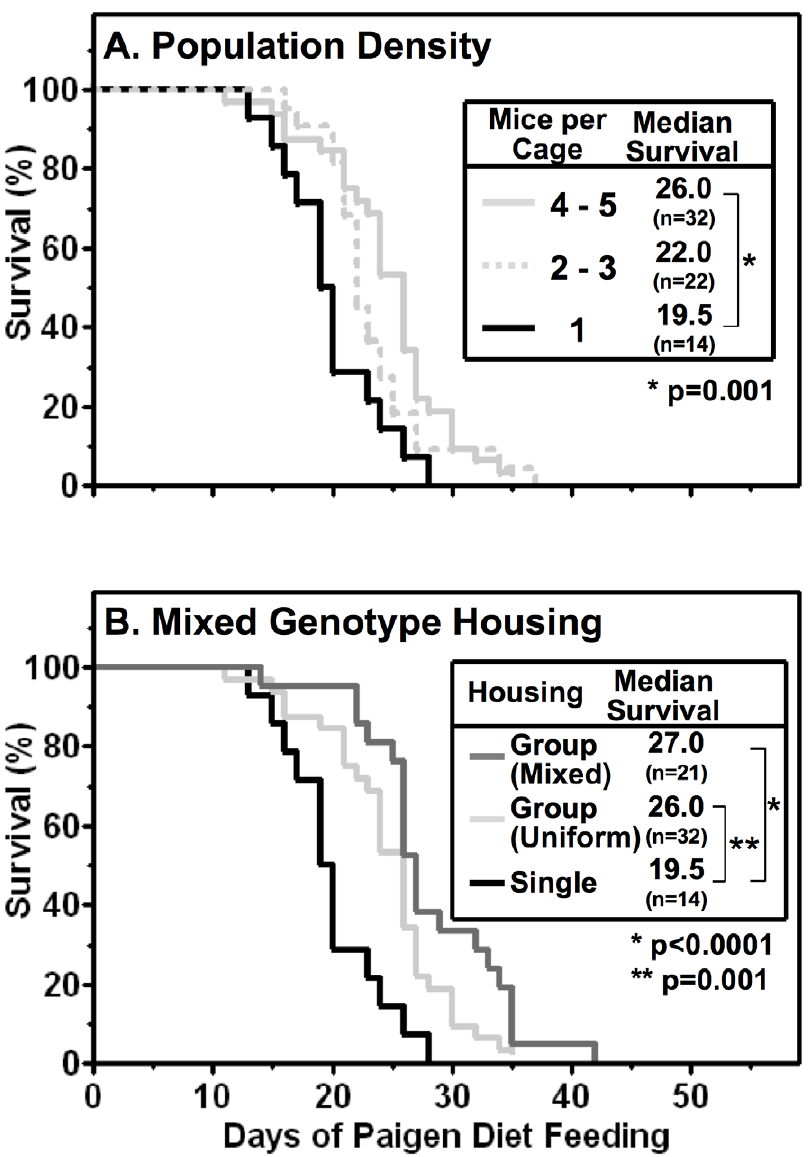
Figure 3. Population density (A) and mixed genotype housing (B) effects on Paigen diet-fed HypoE mouse survival. Mice were housed at the indicated population densities (1, 2–3 or 4–5 (group)/cage) with either uniform (HypoE) or mixed genotypes (HypoE and one or more SRBI + / 2 ApoeR61 h/h littermates per group). Beginning at two months of age the animals were switched from a normal chow diet to the standard Paigen diet. The data shown include only the HypoE mice. A Kaplan-Meier survival curves for HypoE mice housed singly (1 mouse/cage, black line), or uniform genotype (HypoE only) groups of 2–3 (light gray dashed line), or 4–5 (light gray solid line) mice per cage with the indicated median survival times and number of animals per group (n). A notch in the 4–5 mice per cage line indicates a censored animal that was euthanized due to severe ulcerative dermatitis at 35 days after initiating Paigen diet feeding. B Kaplan-Meier survival curves for HypoE mice housed singly (black line) or in uniform genotype (HypoE only, light gray line) or mixed genotype (HypoE and SRBI + / 2 ApoeR61 h/h E, gray line) group housing (4–5 mice/cage).